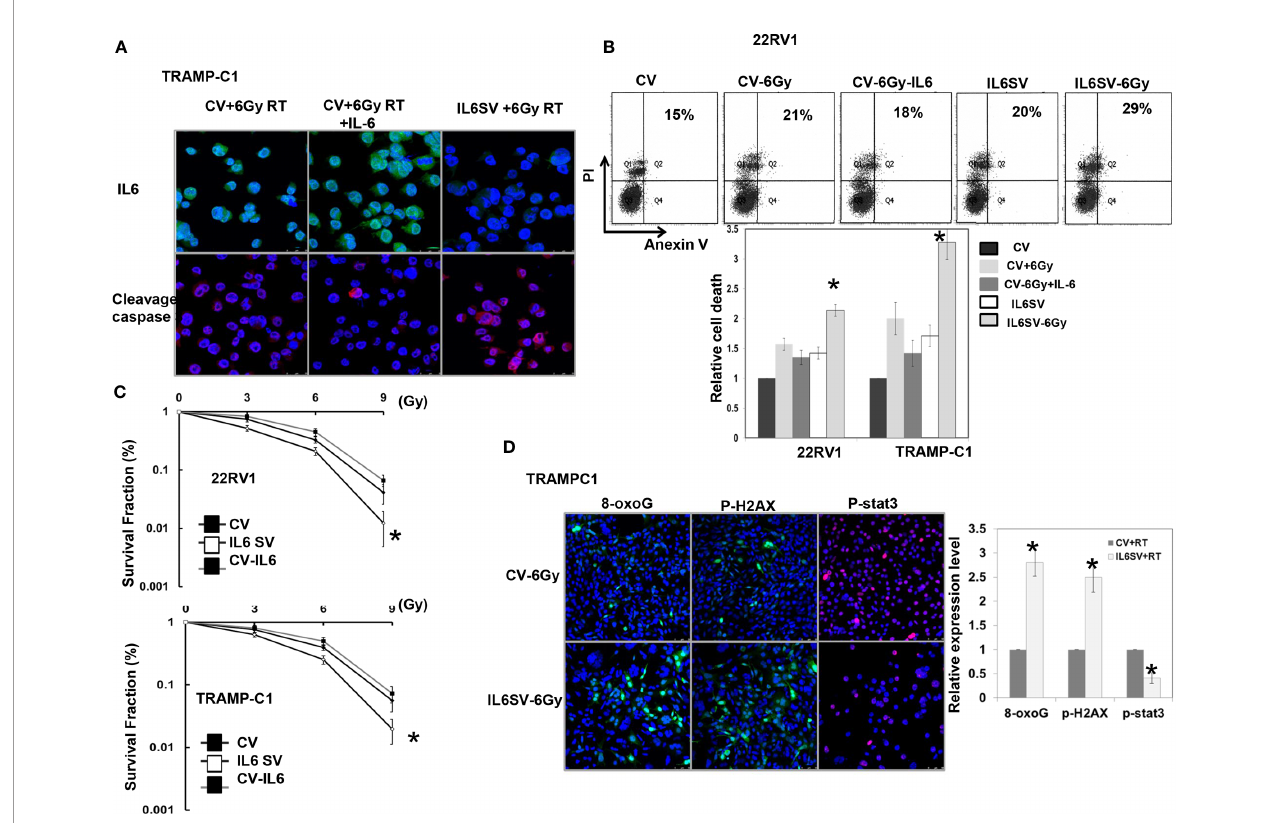
FIGURE 1 | Effects of IL6 on radiation responses in vitro. (A) IL6 silencing vectors signi fi cantly decreased IL6 expression associated with increased apoptosis- related proteins by immuno fl uorescence in vitro (DAPI, blue; Cleavage caspase 3, red; IL-6, green). (B) The in vitro effects of IL6 on apoptosis and cell death, as evaluated by FACS with Annexin V-PI staining in irradiated cells. The data revealed that IL-6 inhibition increased apoptosis in irradiated cells. (C) Cells were irradiated with 0, 3, 6, or 9 Gy, and the survival curves were determined by colony-formation assay. The survival fraction was determined by enumerating colonies after irradiation exposure divided by the plating ef fi ciency of the respective cells. Points, means of 3 separate experiments; bars, SD. *P < 0.05. (CV: prostate cancer cells transfected with control vectors; IL6 SV: prostate cancer cells transfected with IL-6 silencing vectors) (D) IL6 silencing vectors signi fi cantly decreased activated stat3 expression associated with increased DNA damage after RT, as demonstrated by immuno fl uorescence in vitro . The quanti fi cation is to calculate the value of the cell number positive for targeted protein divided by the total cell number. The Y-axis represents the ratio normalized by the value of irradiated CV cells. *p < 0.05. (CV: prostate cancer cells transfected with control vectors; IL6 SV: prostate cancer cells transfected with IL-6 silencing vectors; cell-6Gy: transfections with 6Gy irradiation; CV-IL-6: CV cells were treated with IL6 10ng/ml for 3 days before